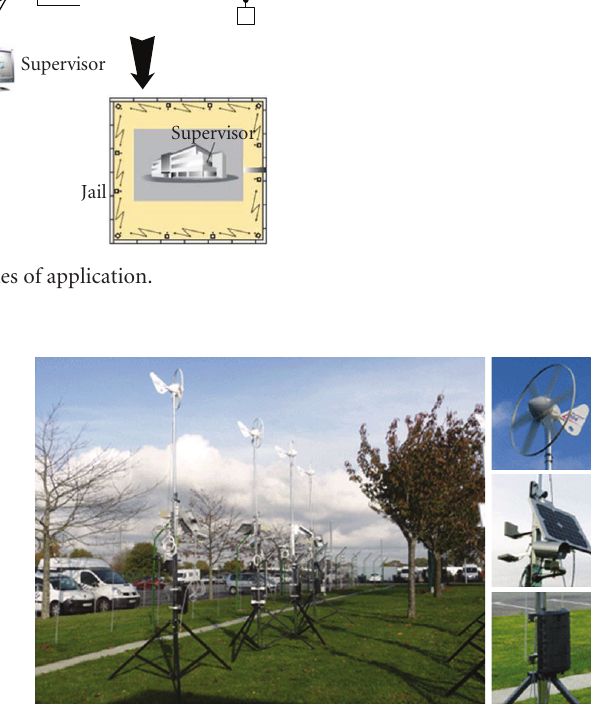
Figure 2: Photo of nodes of the sensor network.